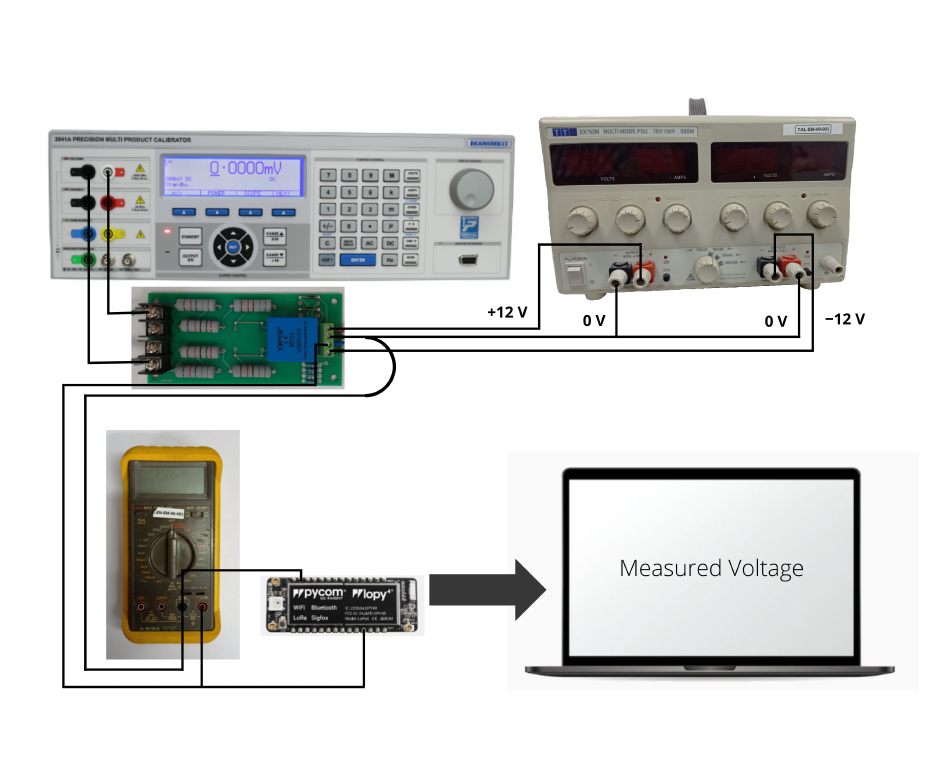
Figure 4. Voltage sensor calibration assembly. Transmille 3000A Series calibrator and voltage sensor.